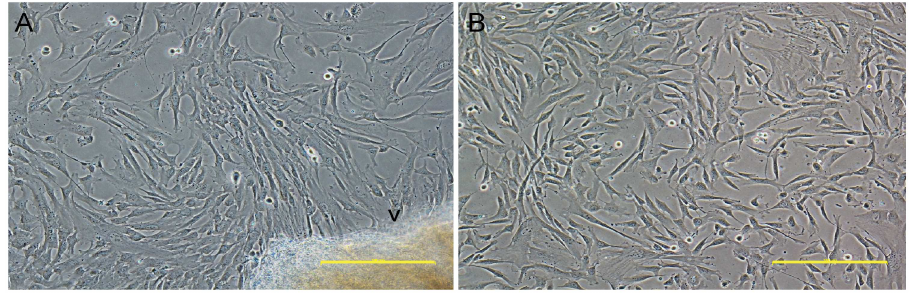
Fig 1. Morphology of hWJ-MSCs with a typical fibroblast-like morphology. (A) Phase contrast images of hWJ-MSCs expanded from Wharton’s jelly tissue (arrow) and (B) hWJ-MSCs at 80% confluences. Scale bar = 10 μ